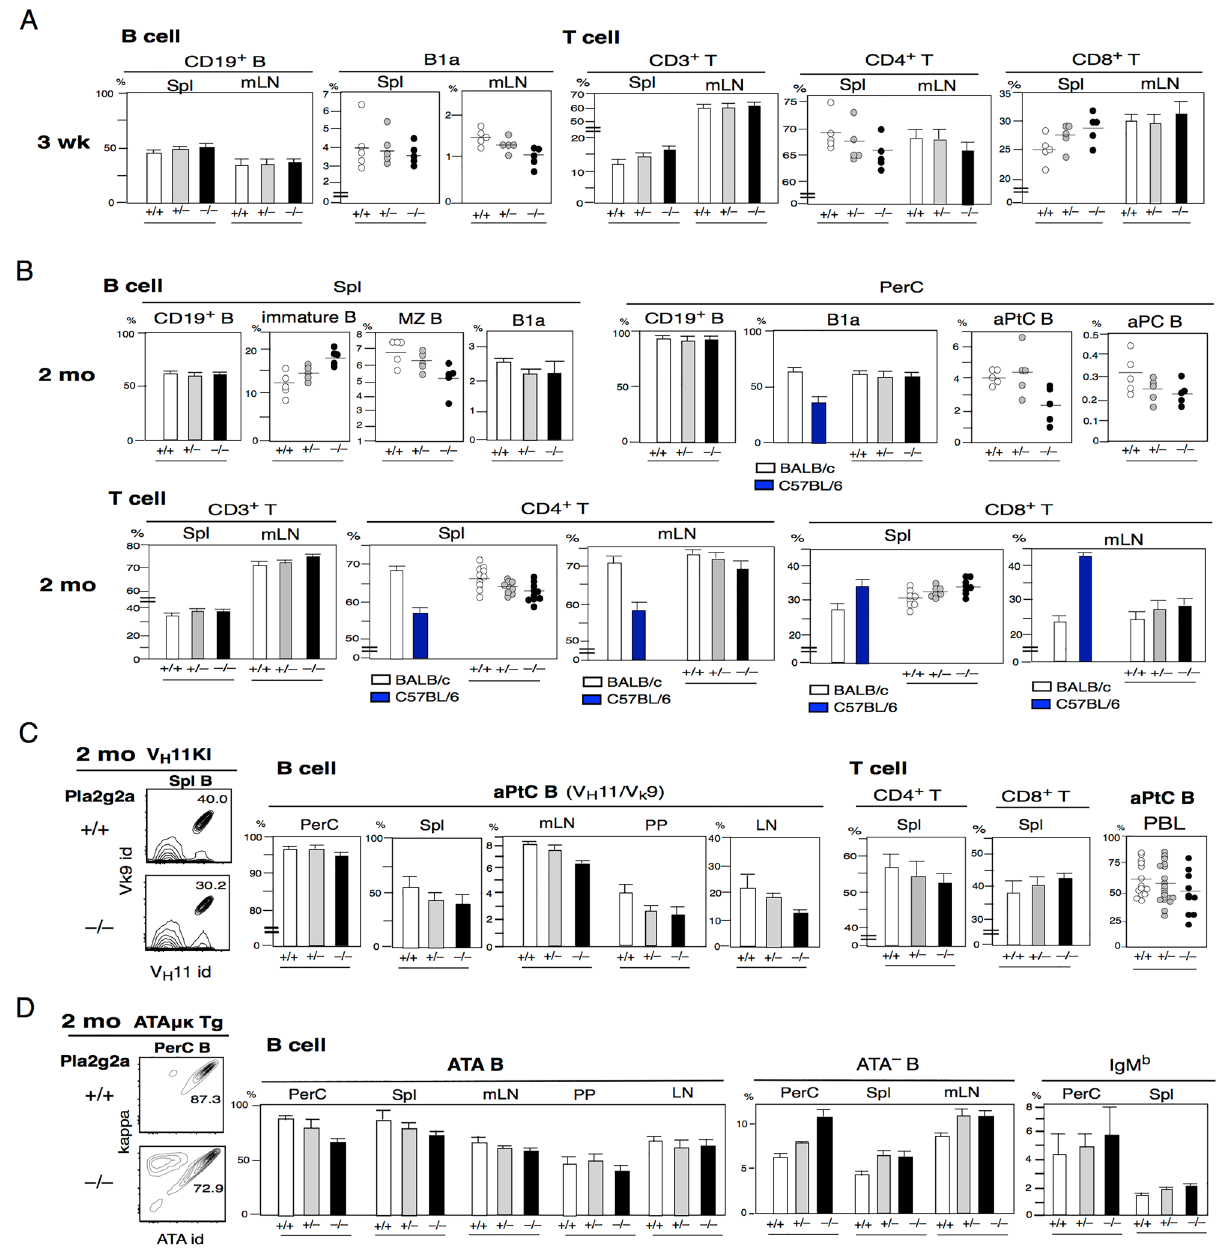
Figure 3. Pla2g2a loss alters B1a, MZ B, and the CD4/CD8 T cell ratio. BALB/c, V H 11KI, and ATAμκTg mice under Pla2g2a + / + , + /–, –/– backgrounds were subjected to analysis for B and T cells. The majority of data showed the mean ± SE, and some showed individual data with mean percentages and + / + vs –/– P-values as calculated by t-test. ( A ) B (CD19 + ) and T (CD3 + ) cell analysis of 3 wk Pla2g2a + / + , + /–. –/– mice (n = 5 each). For + / + vs –/–: Spl B1a; P = 0.429, mLN B1a; P = 0.035. Spl CD4 + T; P = 0.0015, Spl CD8 + T; P = 0.0002. ( B )